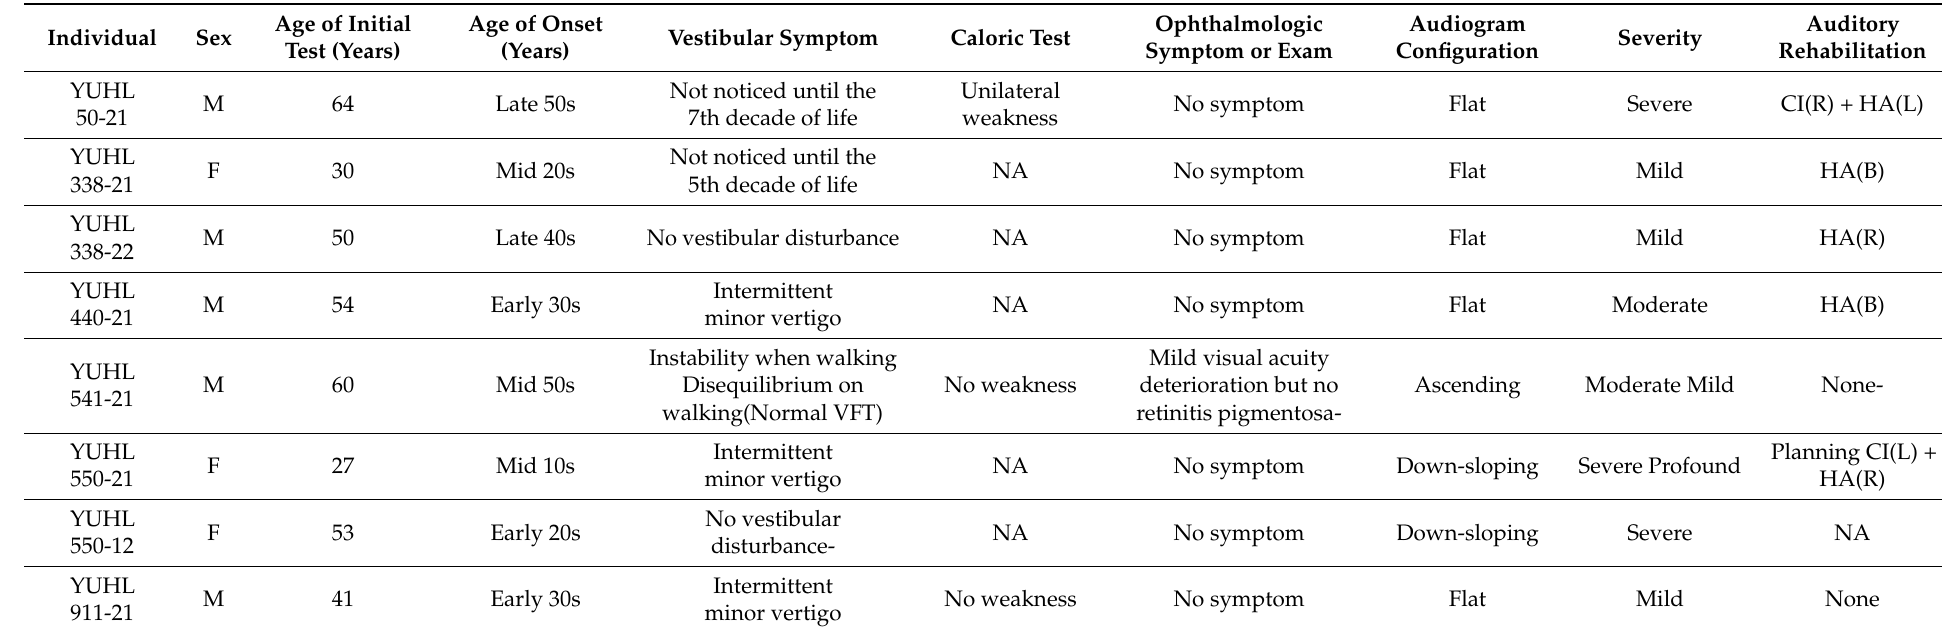
Table 2. Clinical profiles of individuals with DFNA11 in YUHL